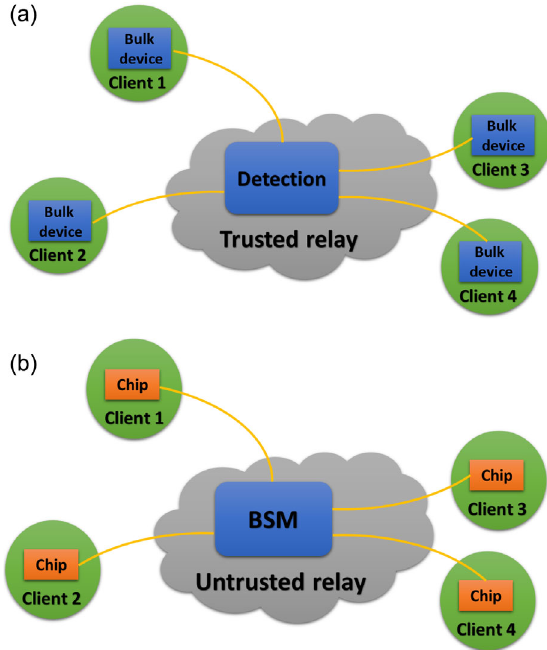
FIG. 1. (a) Schematic of a conventional quantum access net- work based on BB84 [6]. The central relay needs to be trustful, where the measurement devices are vulnerable to quantum attacks. (b) Schematic of the proposed star-type chip-based MDI QKD network. Each client holds only a compact, low-cost transmitter chip, and the central relay performs the Bell-state measurement (BSM). MDI QKD enables secure QKD with an untrusted